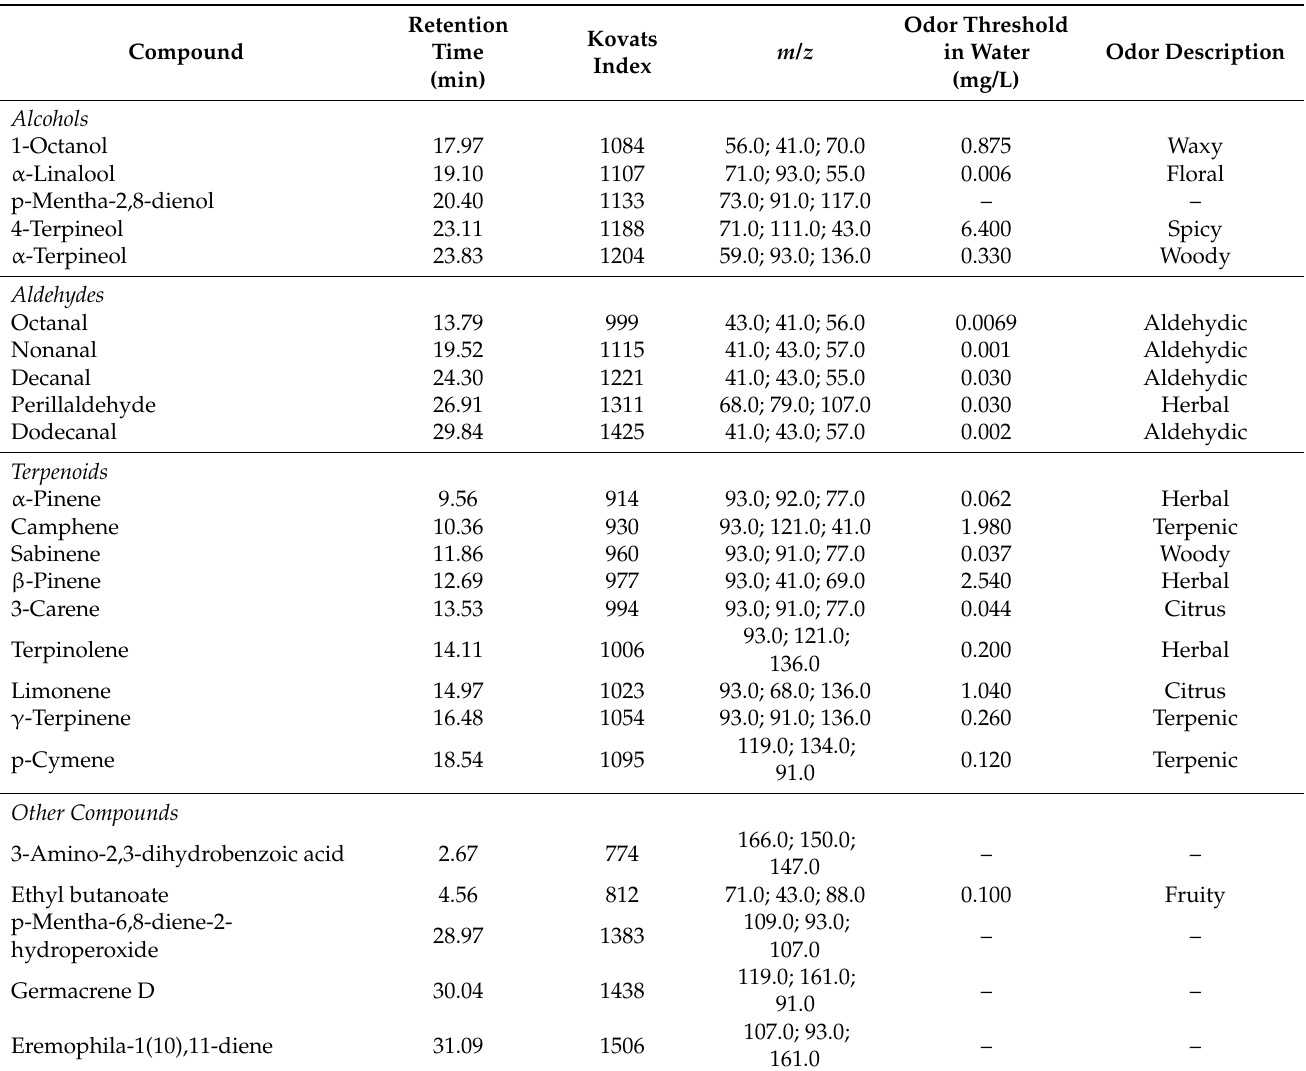
Table 1. Volatile compounds identified in orange juice and their respective retention times (RTs), Kovats indices, odor thresholds in water, and primary odor descriptions. Odor thresholds and descriptions were taken from the literature